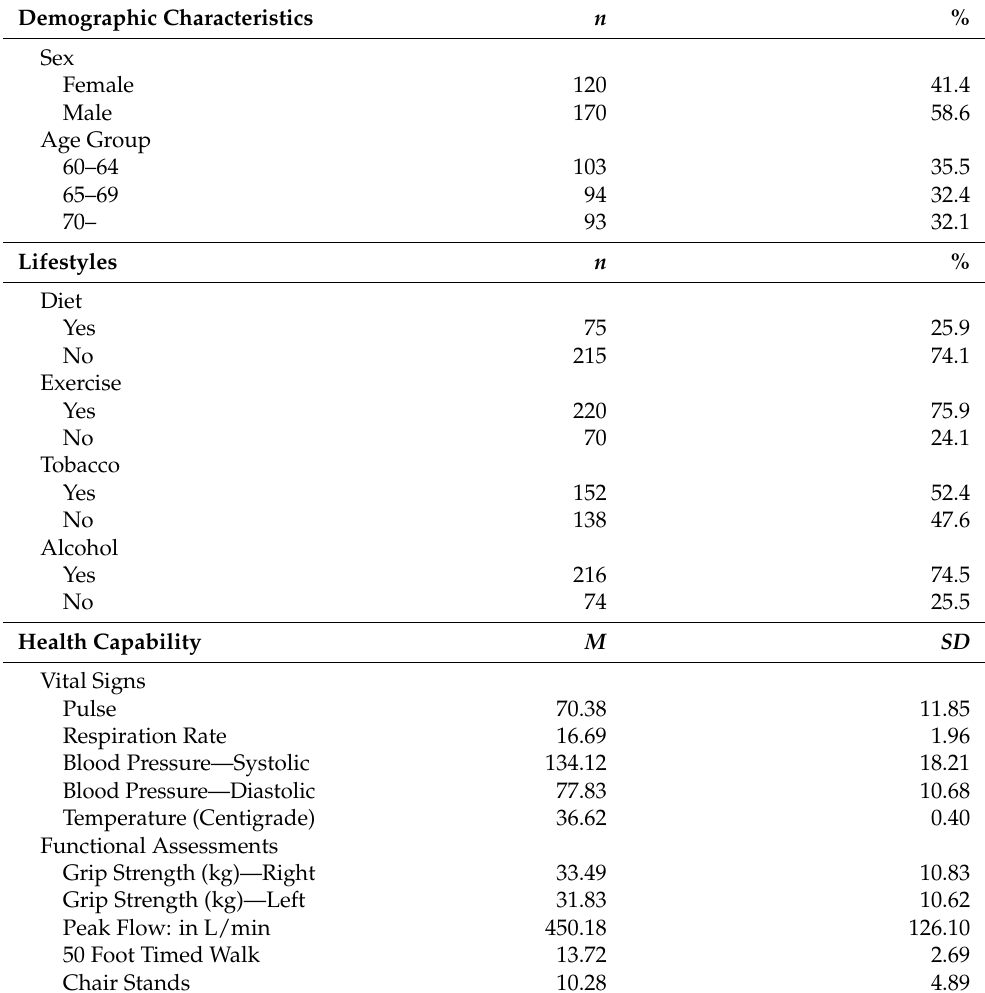
Table 1. Research participants’ demographic characteristics and descriptive statistics of lifestyles and health